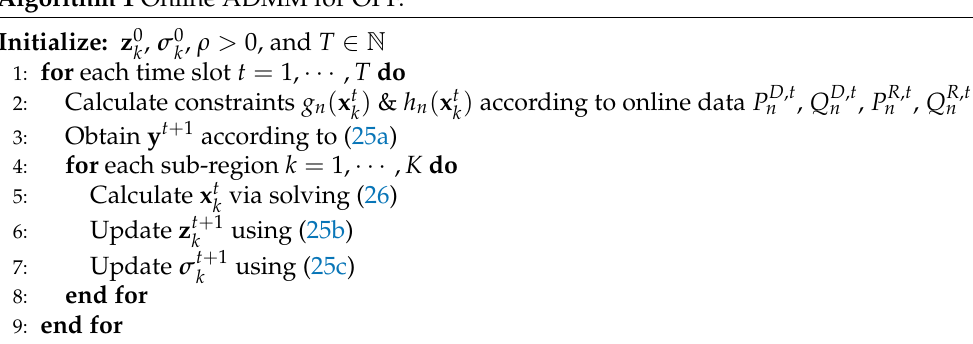
Algorithm 1 Online ADMM for OPF.